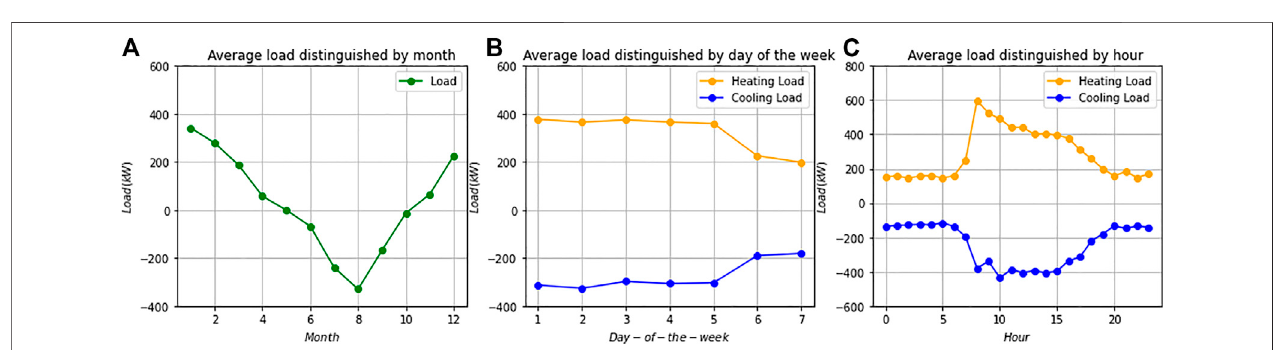
FIGURE 4 | The diagram of average load distributed by the time: (A) average load distinguished by month, (B) average load distinguished by day of the week, (C) average load distinguished by hour.